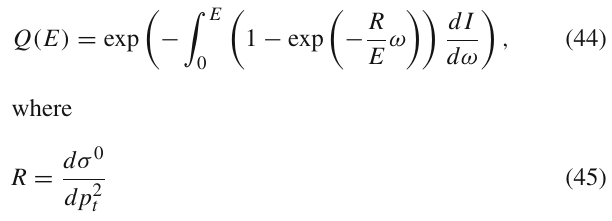
Table 1 The estimate for quenching coefficients S(E) for light and heavy quarks, for L = 4 fm width. The jet quenching factor Q ( E ) = exp ( S ( E )) Here α s = 0 . 3.TheBDMPSmeansquenchingweightcalcu- lated in the harmonic oscillator approximation with constraint k t ≤ ω , ω ≤ E . BDMPS+Coulomb means quenching weights calculated in the Moliere Theory (BDMPS plus Coulomb logarithms) with the same limitation